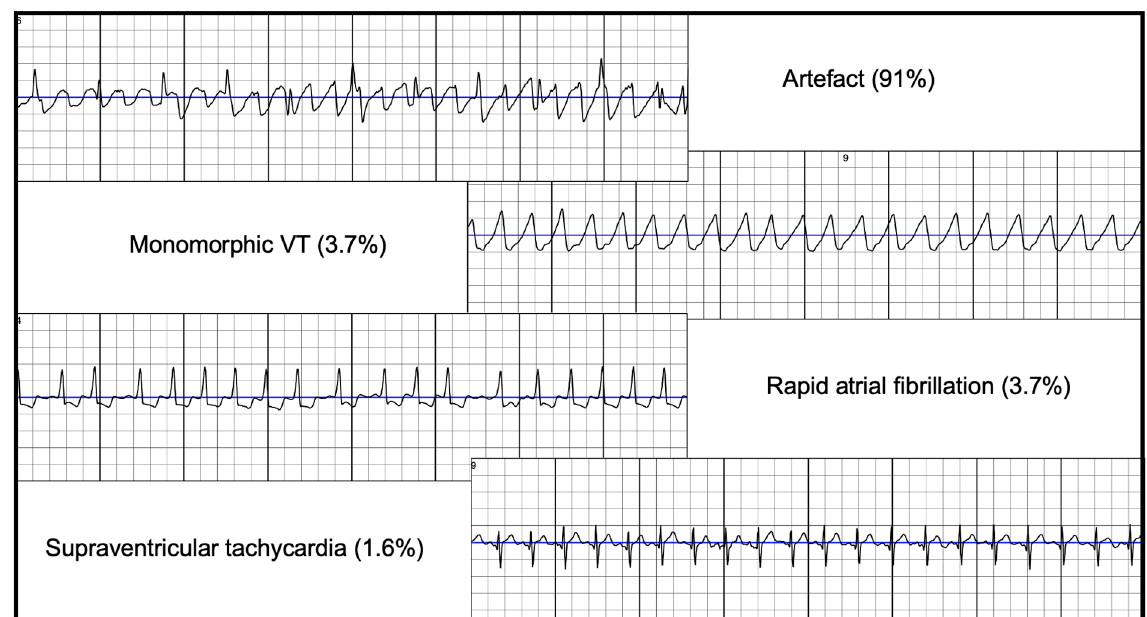
Figure 2. Categories of analysed recordings ( n = 2996), VT = ventricular